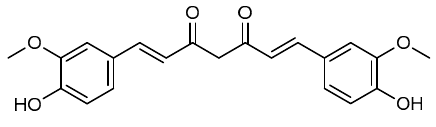
Figure 2. Curcumin ( 1